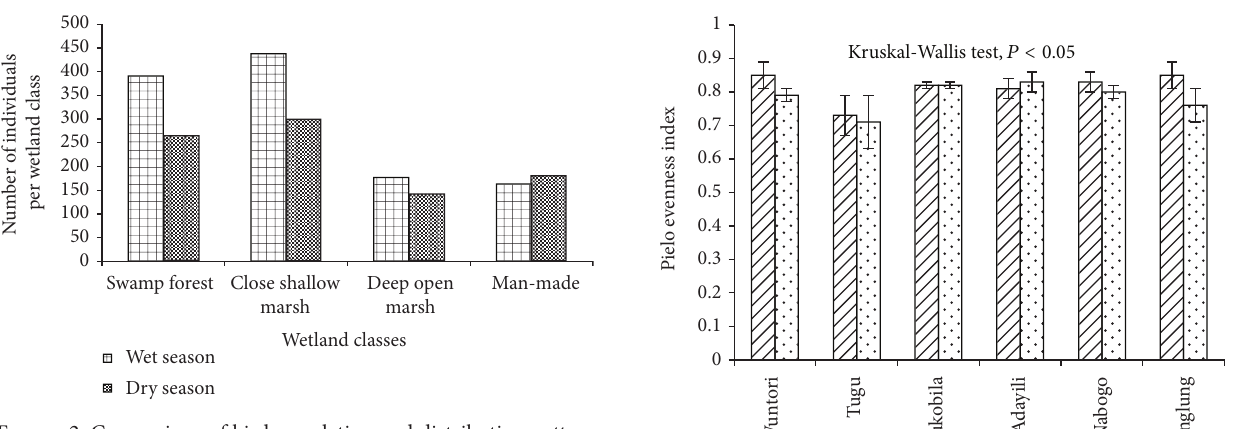
Figure 2: Comparison of bird population and distribution pattern among the different wetland classes in both wet and dry seasons.